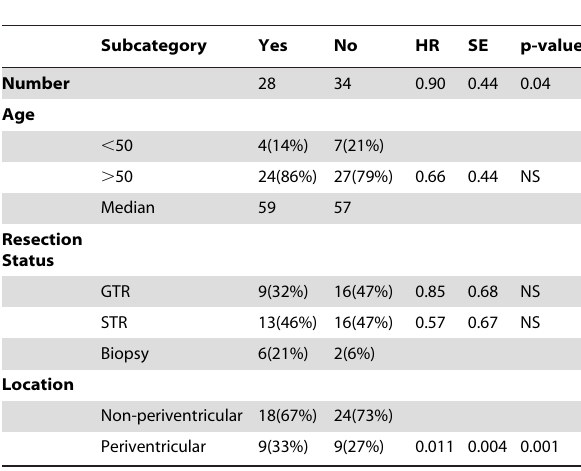
Table 4. Bevacizumab Usage at